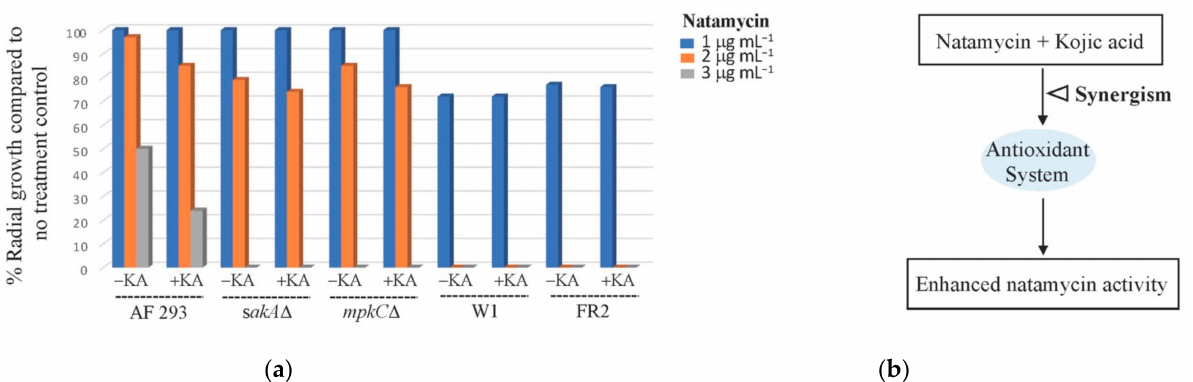
Figure 5. ( a ) The level of fungal growth without or with the treatment of natamycin (NAT) (1, 2, 3 µ g mL − 1 ) and/or kojic acid (KA) (5 mM) tested in A. fumigatus (AF293 (wild type), MAPK mutants ( sakA ∆ , mpkC ∆ )) and P. expansum (W1 (wild type), FR2 (FLU-resistant mutant)) (triplicate) (SD < 2%); ( b ) diagram: enhanced NAT activity by combined application of